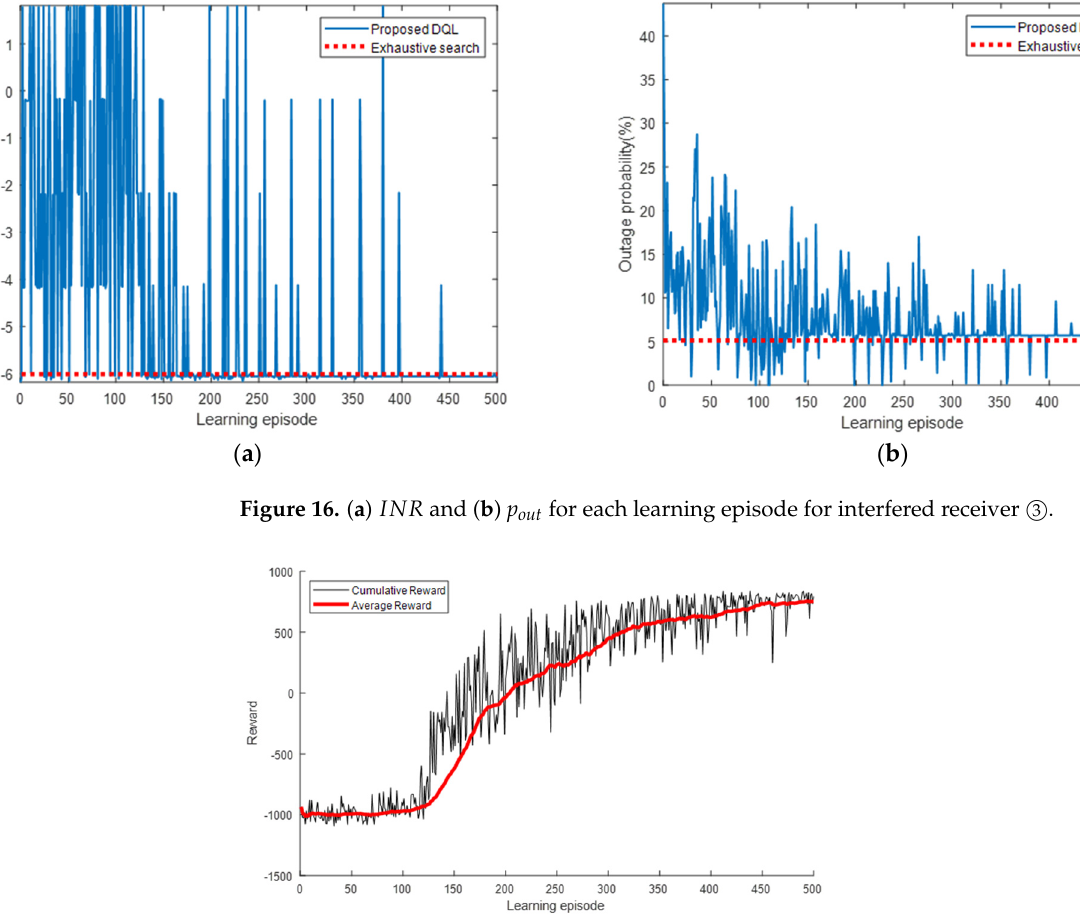
Figure 17. Reward for each learning episode for interfered receiver ③ .